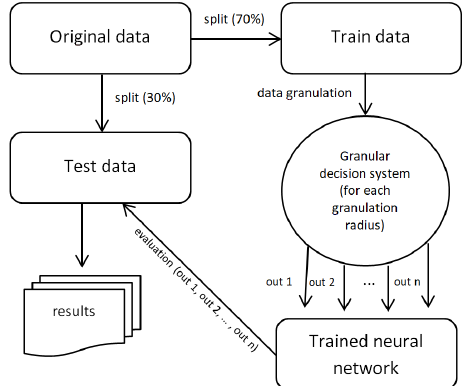
Figure 1. The diagram shows a scheme of our experimental part. The exact design of the neural network is in Figure 3. The data that is fed into the neural network is normalized after granulation to a range of < 0,1 >